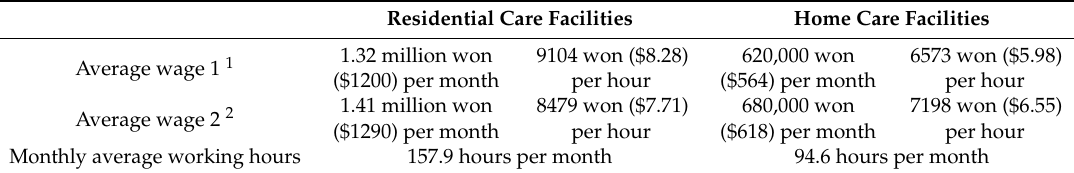
Table 3. Current status of average wage and monthly average working hours.